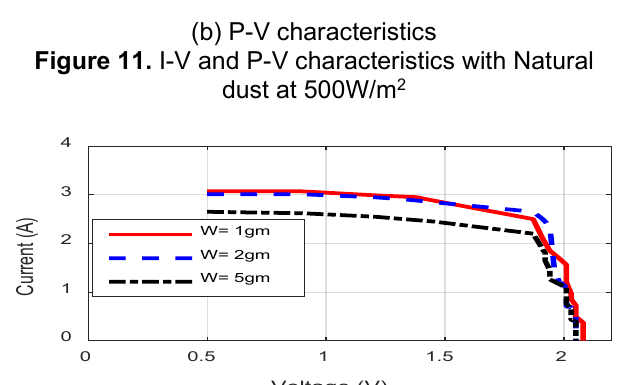
Figure 11. I-V and P-V characteristics with Natural dust at 500W/m 2